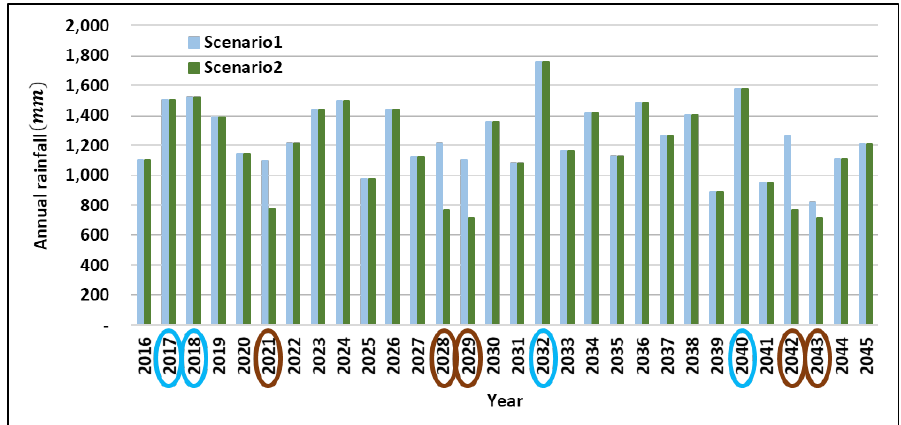
Figure 5. Annual rainfall with scenarios 1 and 2 (blue circle indicates flood years and brown circle indicates drought years).